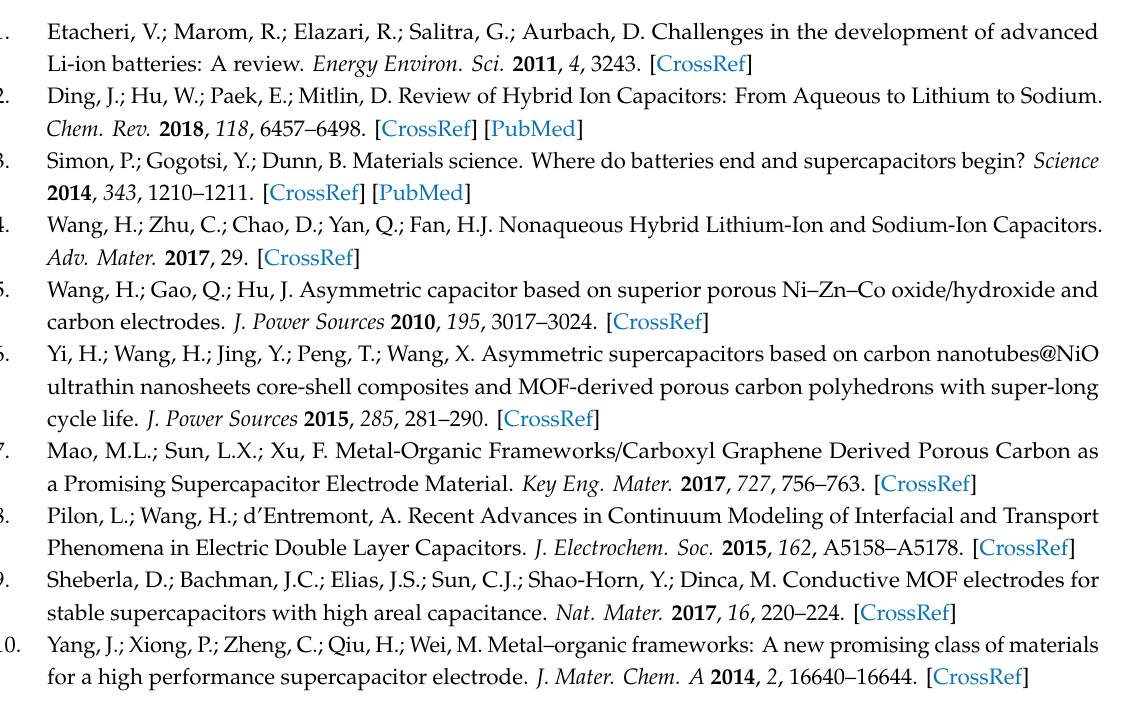
TGA curve for sample IV , Figure S8—optimized geometries for dimeric and trimeric subchains, Figure S9—charge distribution diagram upon the stepwise